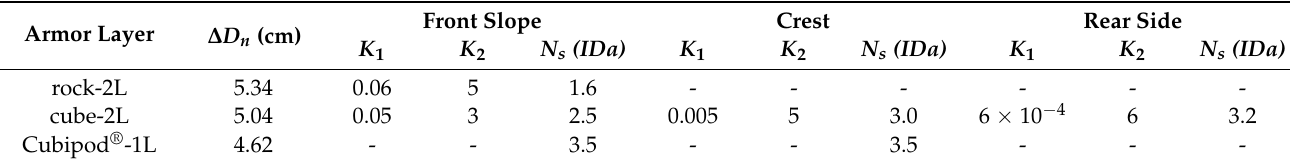
Table 4. Summary of the results of the analysis of the armor damage to overtopped mound breakwaters. Armor Layer ∆ D n (cm)